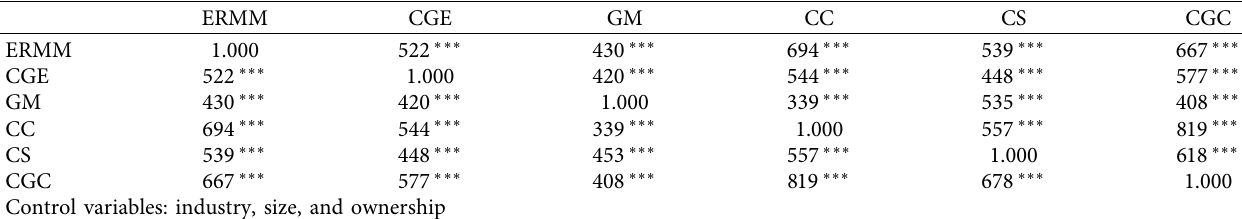
Table 3: Partial correlation coefficient matrix of variables in the enterprise risk management maturity model.